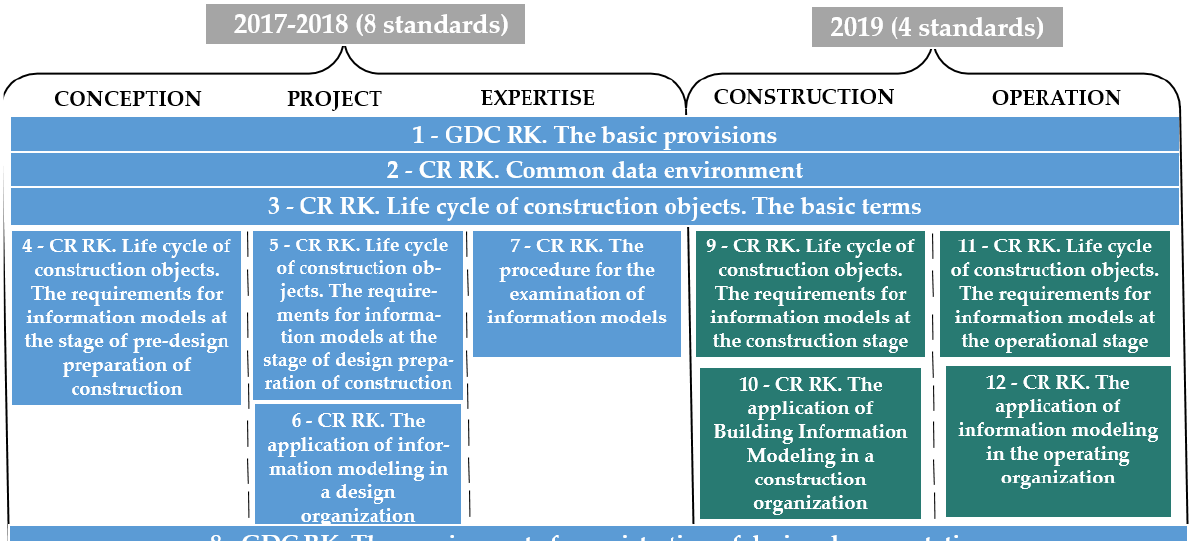
Figure 1. The regulatory framework for the use of BIM technology in Kazakhstan (adapted from [9]). Guiding documents in the construction (GDC) in the Republic of Kazakhstan (RK), Code of rules (CR) of the Republic of Kazakhstan (RK). Table 2. Conducted research on BIM technology in